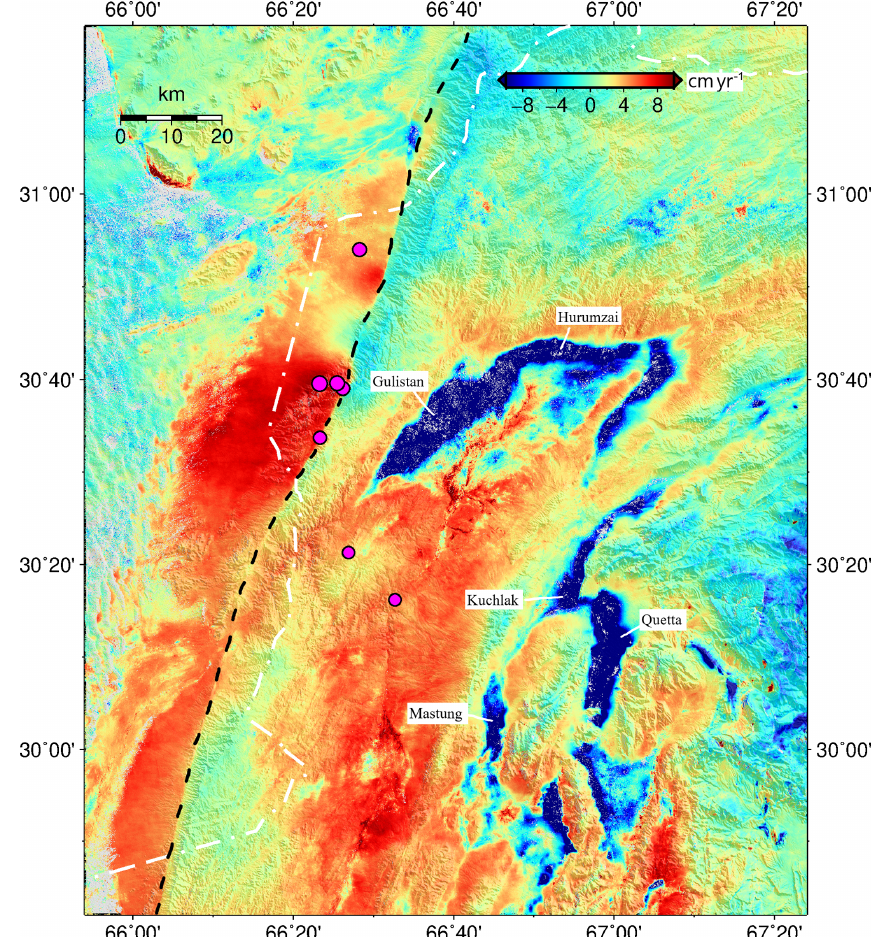
Figure 5. InSAR Map© showing subsidence in Blue which is 8–10cmyr − 1 , red color (saturated) is showing uplifting due to tectonic activity. Black dash line is showing Chaman transform plate boundary, pink dots shows recent earthquakes. InSAR velocities were derived from C-band Sentinel-1 SAR data collected from October 2014 to March